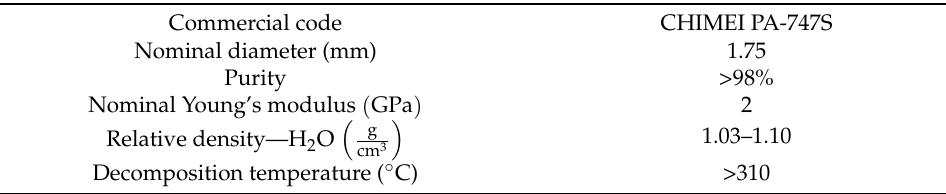
Table 1. Properties of the ABS filaments. Commercial